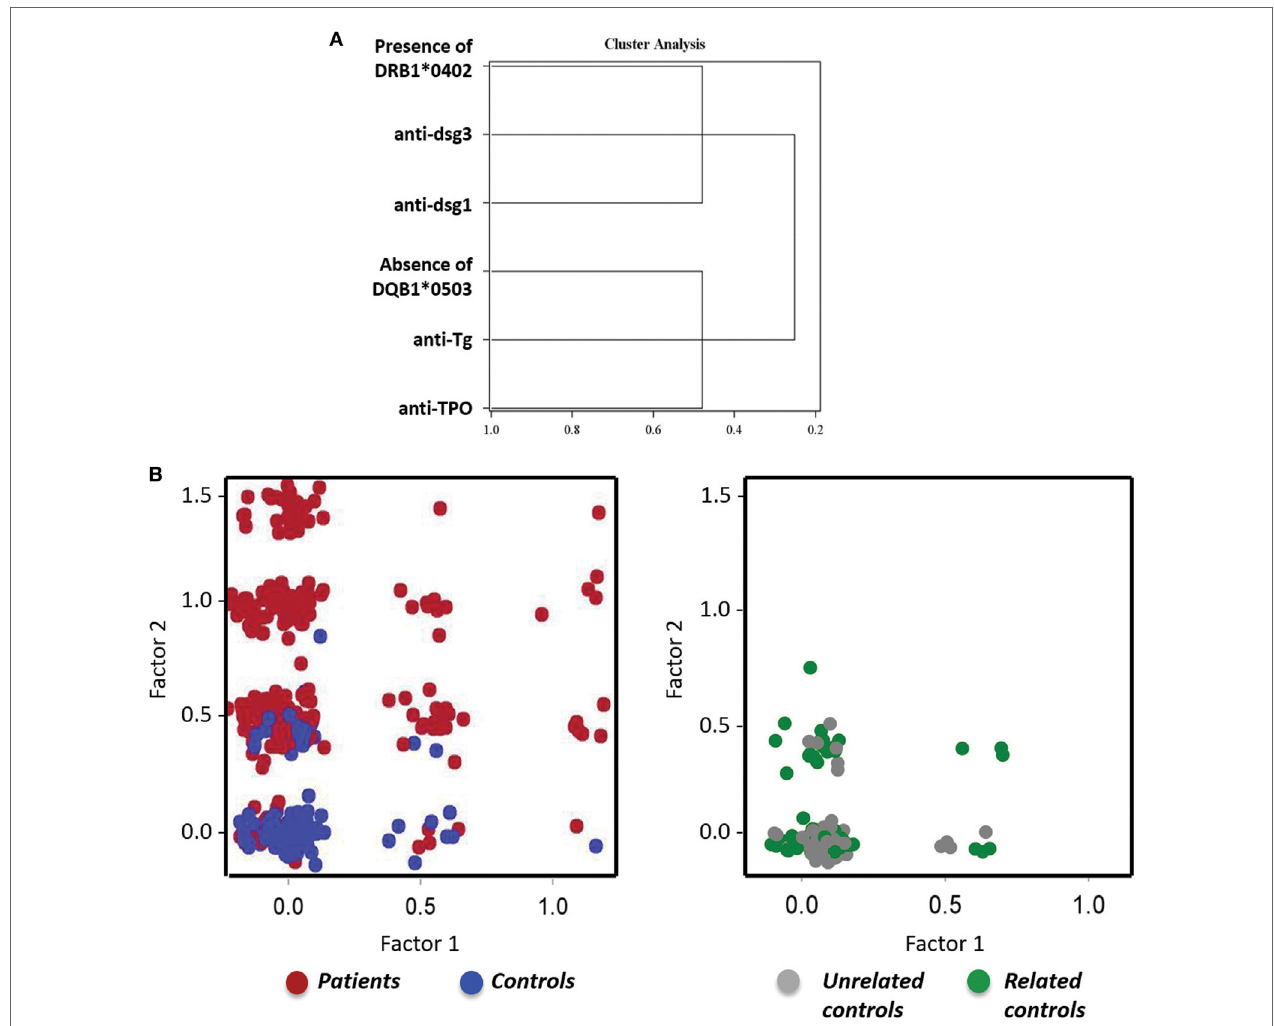
FigUre 7 | Distinct clustering of anti-Dsg antibodies, anti-thyroid antibodies, and human leukocyte antigen (HLA). (a) A tree diagram visually demonstrates the structure and relationship of the clustering variables with anti-Dsg3, anti-Dsg1, and HLA DRB1*0402 in one cluster, and anti-thyroid peroxidase (anti-TPO), anti-thyroglobulin (anti-Tg), and DQB1*0503 a second, distinct cluster. (b) Scatter plot representation of pemphigus vulgaris (PV) patients and controls (left) and controls either related or unrelated to PV patients (right), with factor 1 (anti-TPO, anti-TG, and DRB1*0503) on the x -axis and factor 2 (anti-Dsg3, anti-Dsg1, and DQB1*0402) on the y